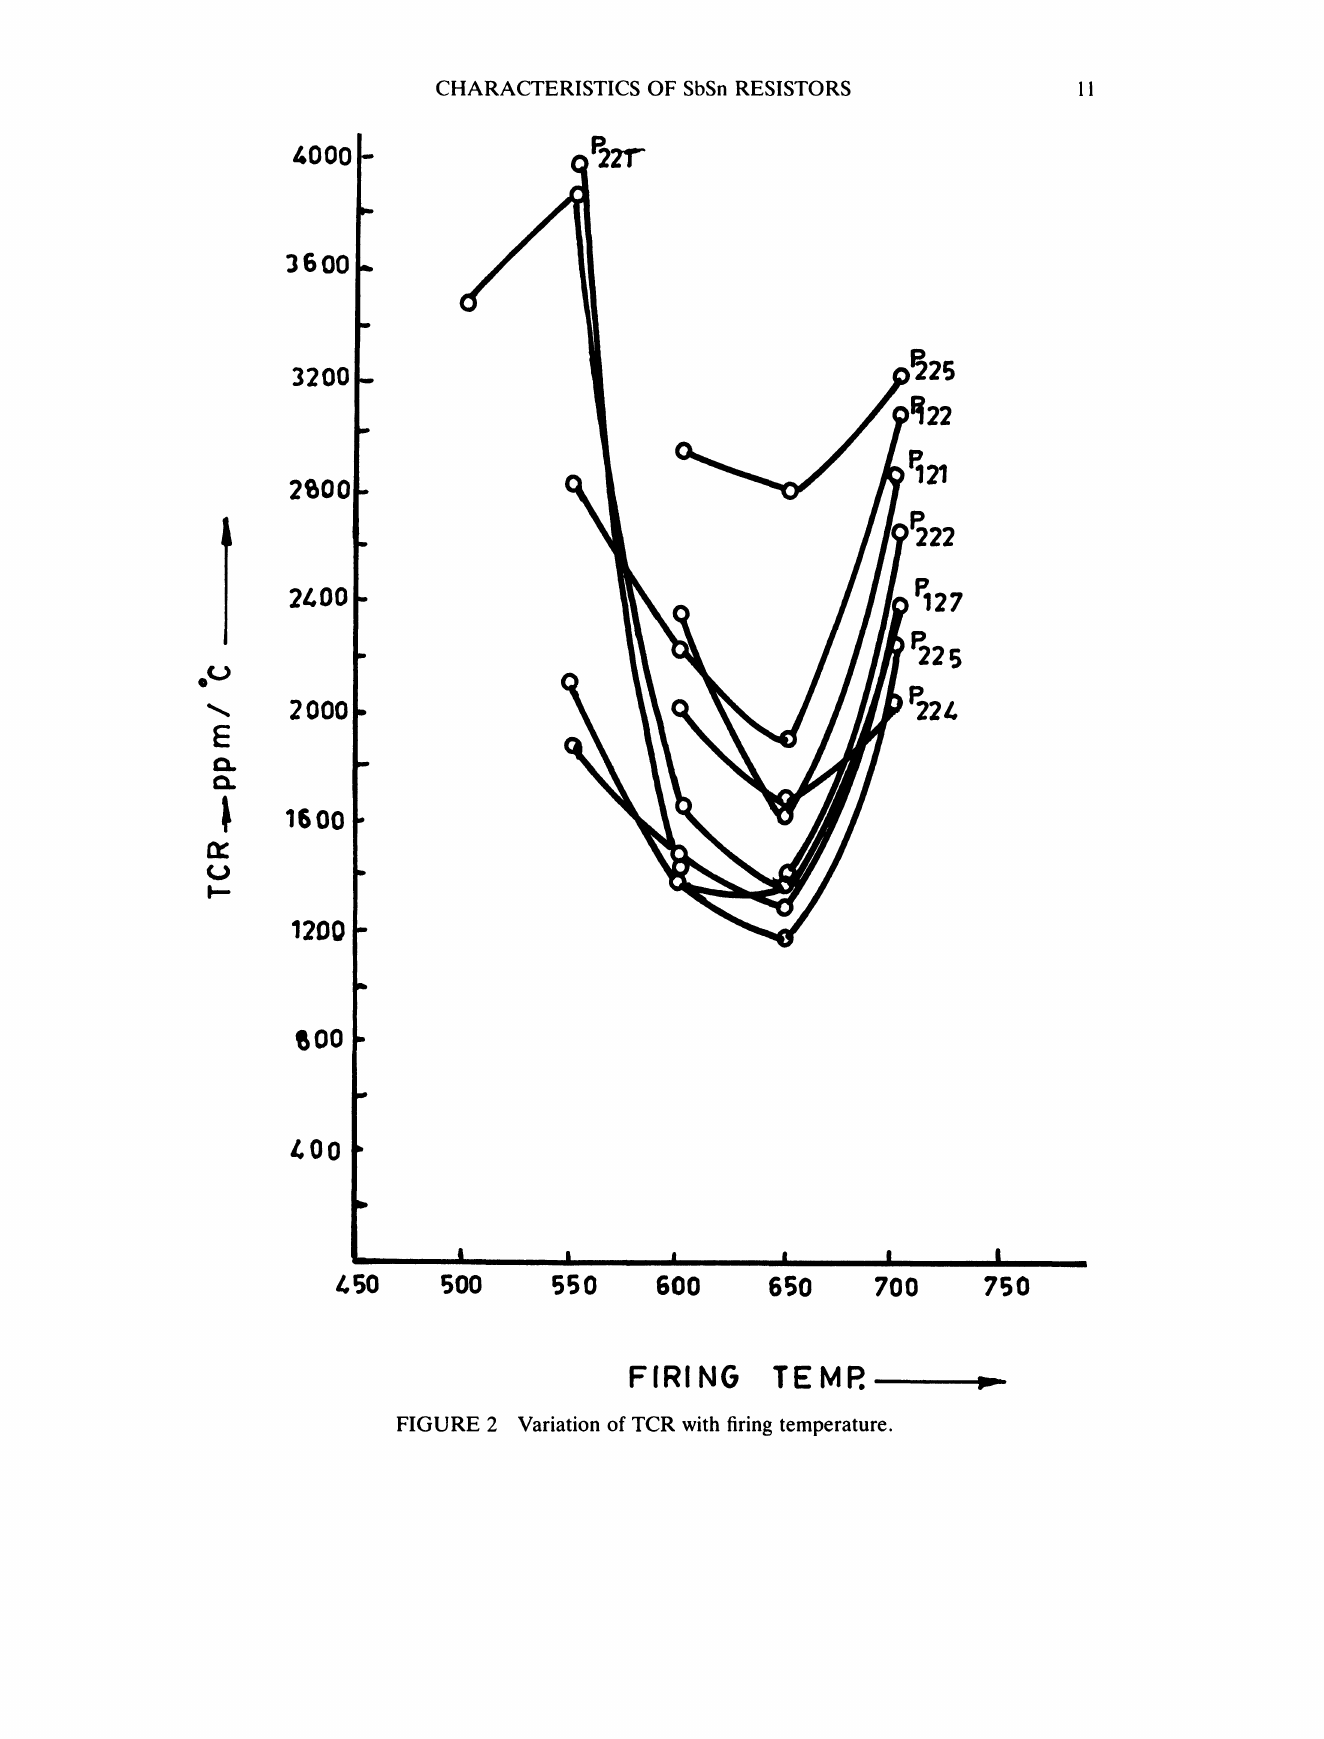
FIGURE 2 Variation of TCR with firing